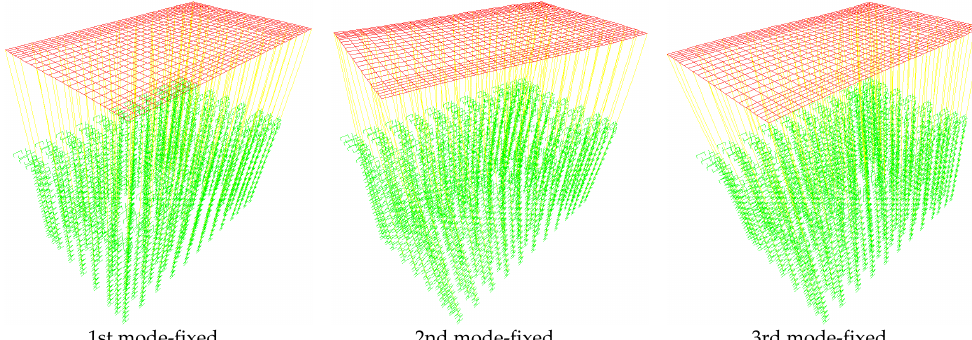
Figure 3. ( i ) The 3D finite element model used in SAP2000 v.17, ( ii ) Illustration of soil springs, and ( iii ) Spring-Gap element (at 1 m under bed